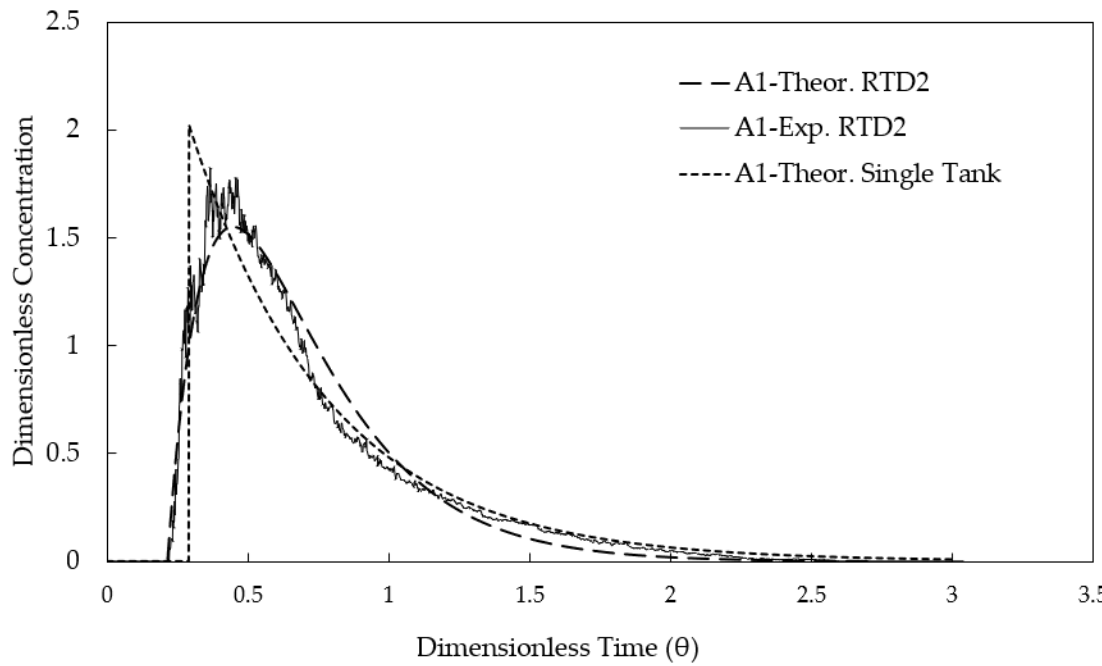
Figure 8. Comparison of experimental and theoretical RTD curves in the entire tundish.